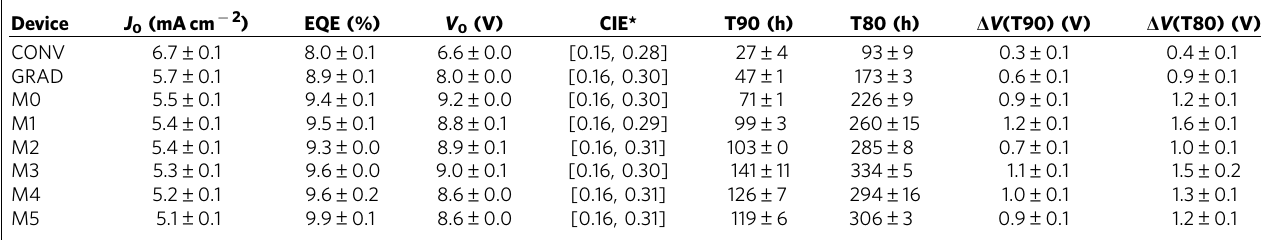
Table 1 | Electroluminescent and lifetime characteristics for CONV, GRAD and managed PHOLEDs (M0–M5) at L 0 ¼ 1,000cd m (cid:2) 2 .